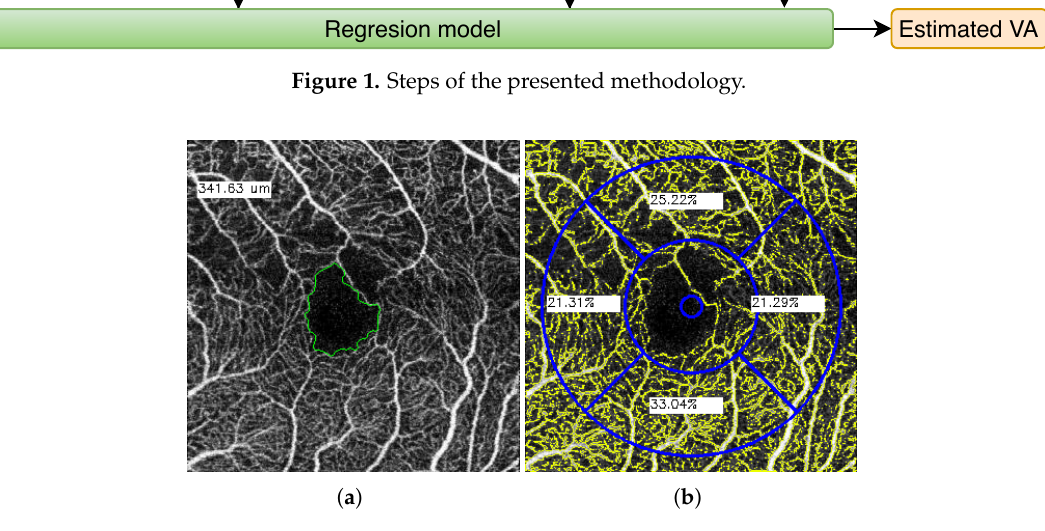
Figure 2. Representative examples of the ( a ) FAZ extraction and ( b ) VD measurement